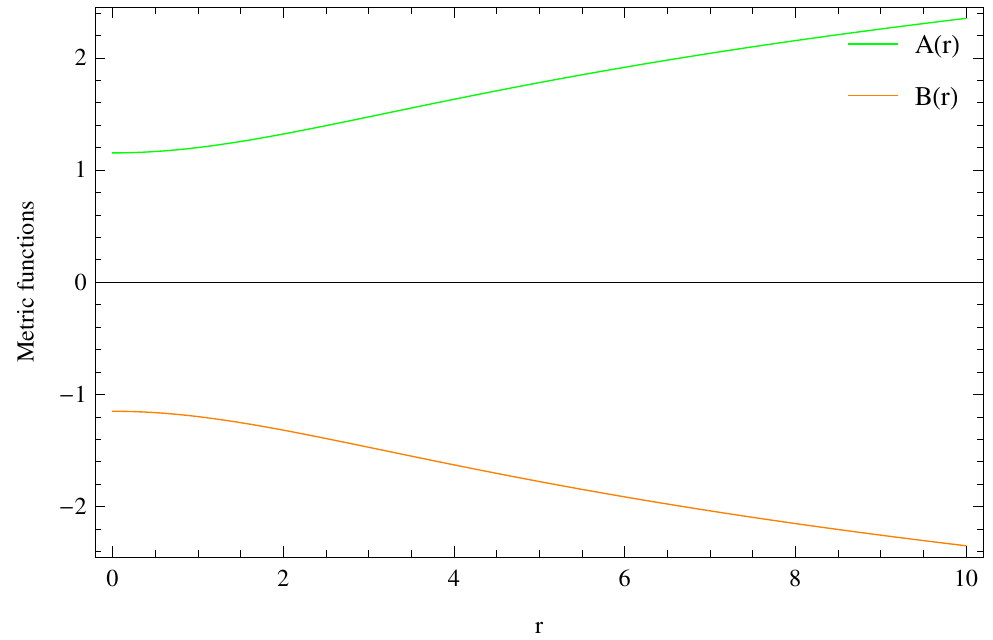
Figure 11 indicates that the metric functions have a finite origin in presence of the cosmological constant term. Figure 12 reveals that the pressure is negative and constant, whereas Figure 13 shows a positive and constant energy density.